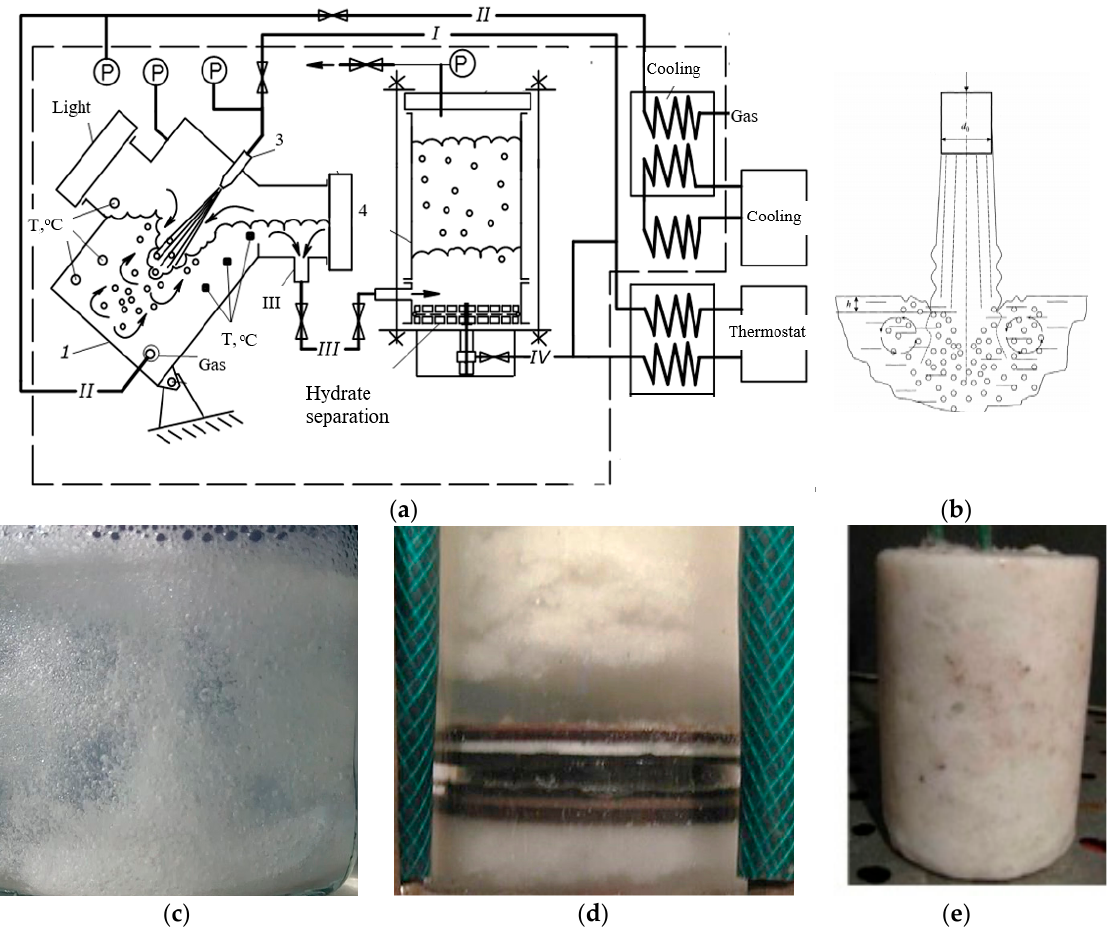
Figure 6. Scheme of plant for gas hydrate production ( a ): 1-reactor; 2-gas; 3-jet apparatus; 4-separator: I, IV-water; II-gas; III-water and gas hydrate mixture: ( b )-injection hydrate formation (phase interface surfaces); ( c )-hydrate formation after hydrate crust destruction; ( d )-separator; ( e )-produced gas hydrate.